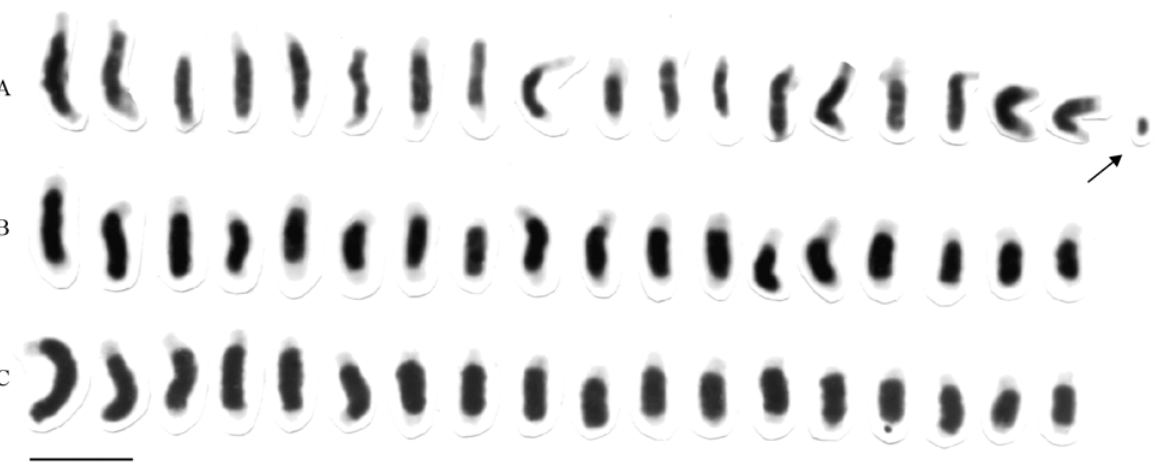
Figure 1 - Karyotypes and C-banding patterns of Melipona rufiventris (A, B) and M. mondury (C). The arrow indicates the B chromosome. Scale bar = 5 μ